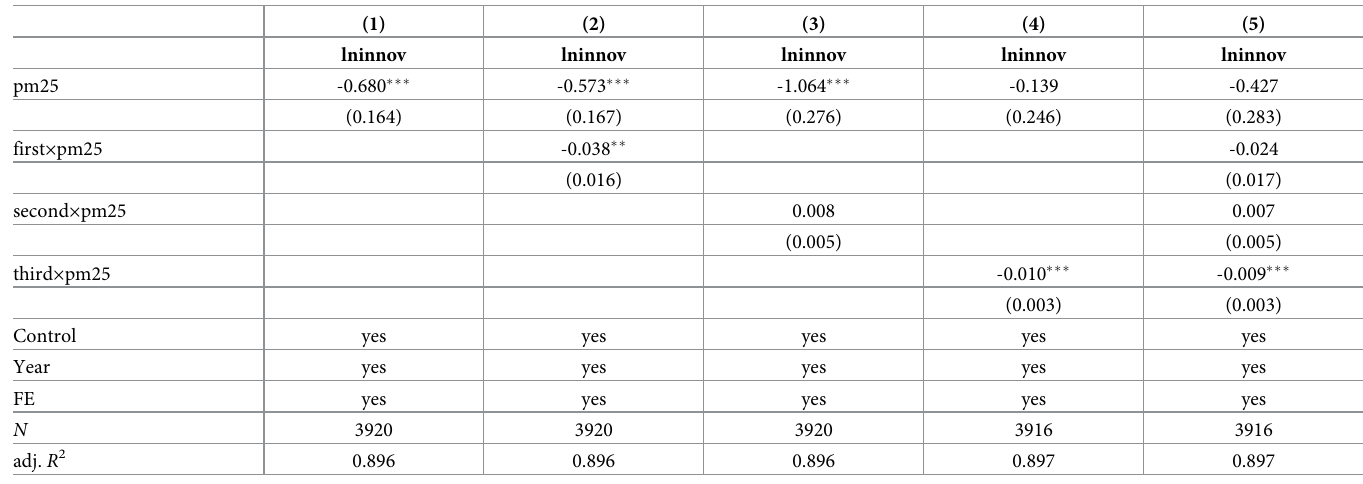
Table 5. Effects of industrial